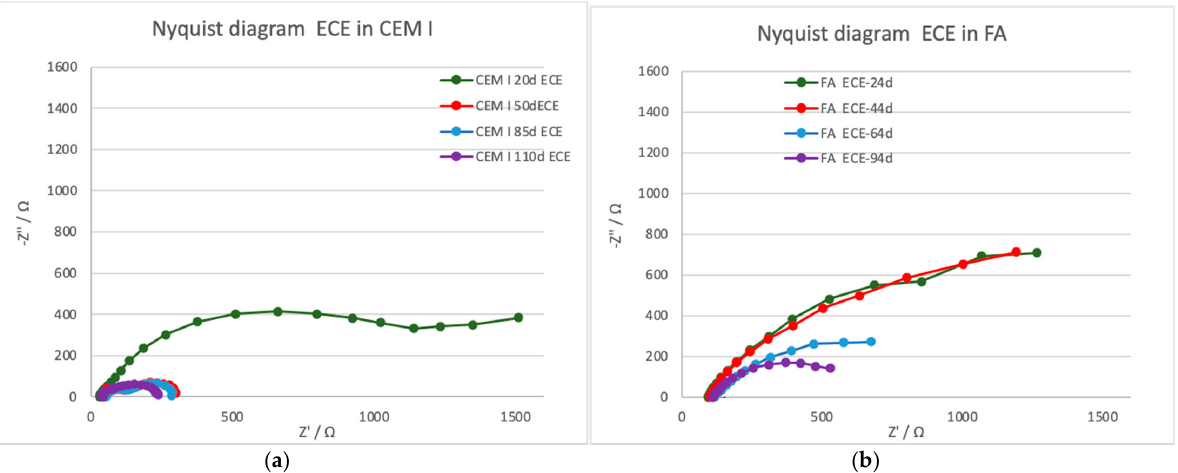
Figure 7. Nyquist diagrams showing the ECE treatment evolution for FA and CEM I mortar typologies. ( a ) CEM I specimens; ( b ) FA specimens.